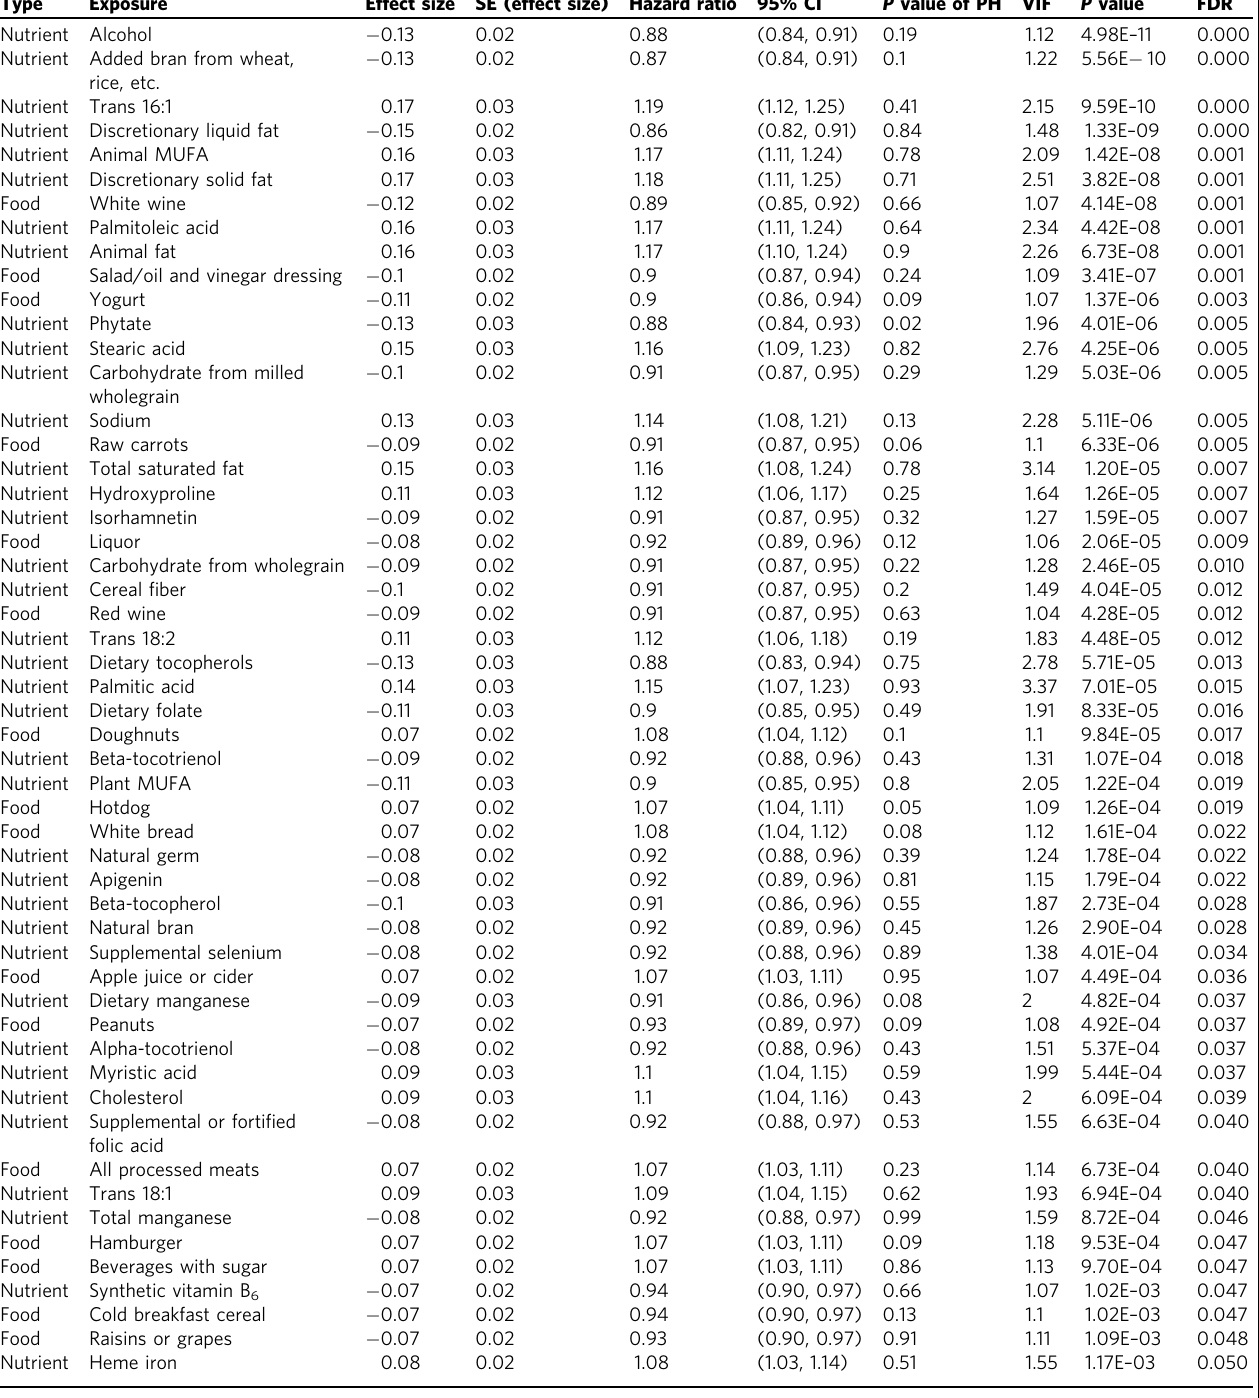
Table 1 EWAS results.